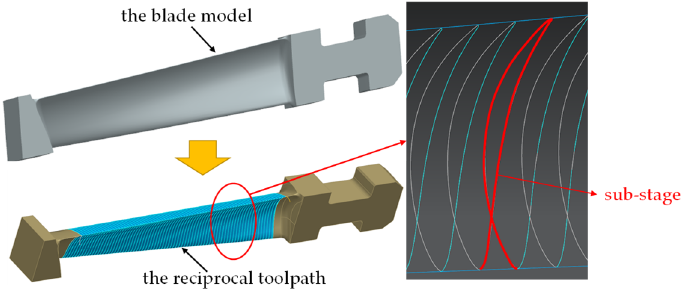
Figure 2. Segmentation of the